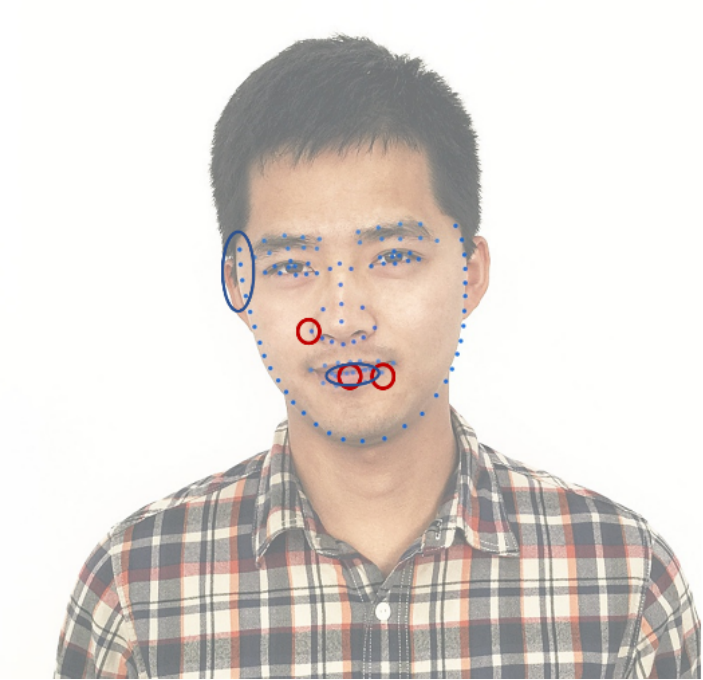
Figure 6. The key points that have a large influence on the classification result.